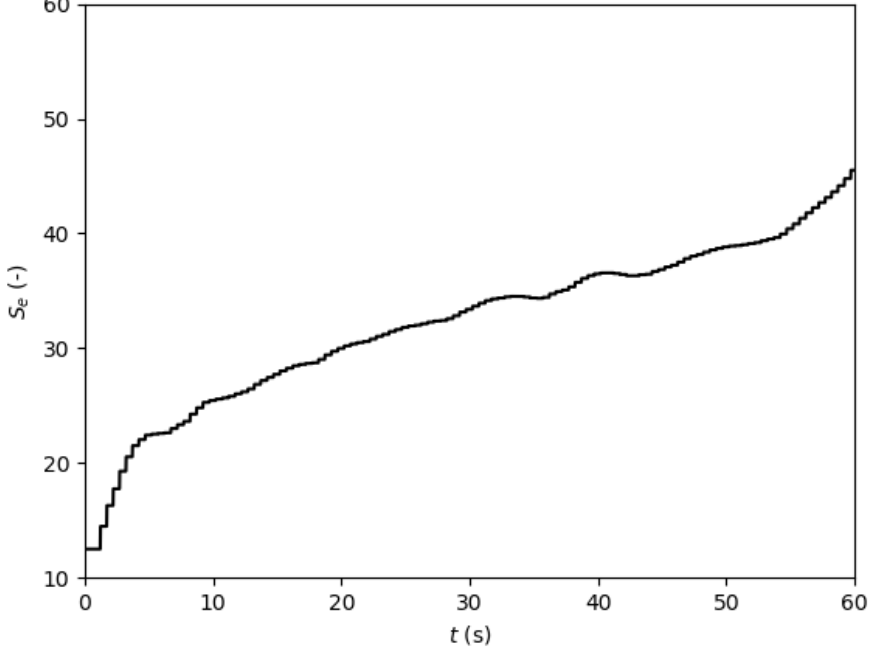
Figure 31. Effective swirl number profile, feedback with complete regulation law, case